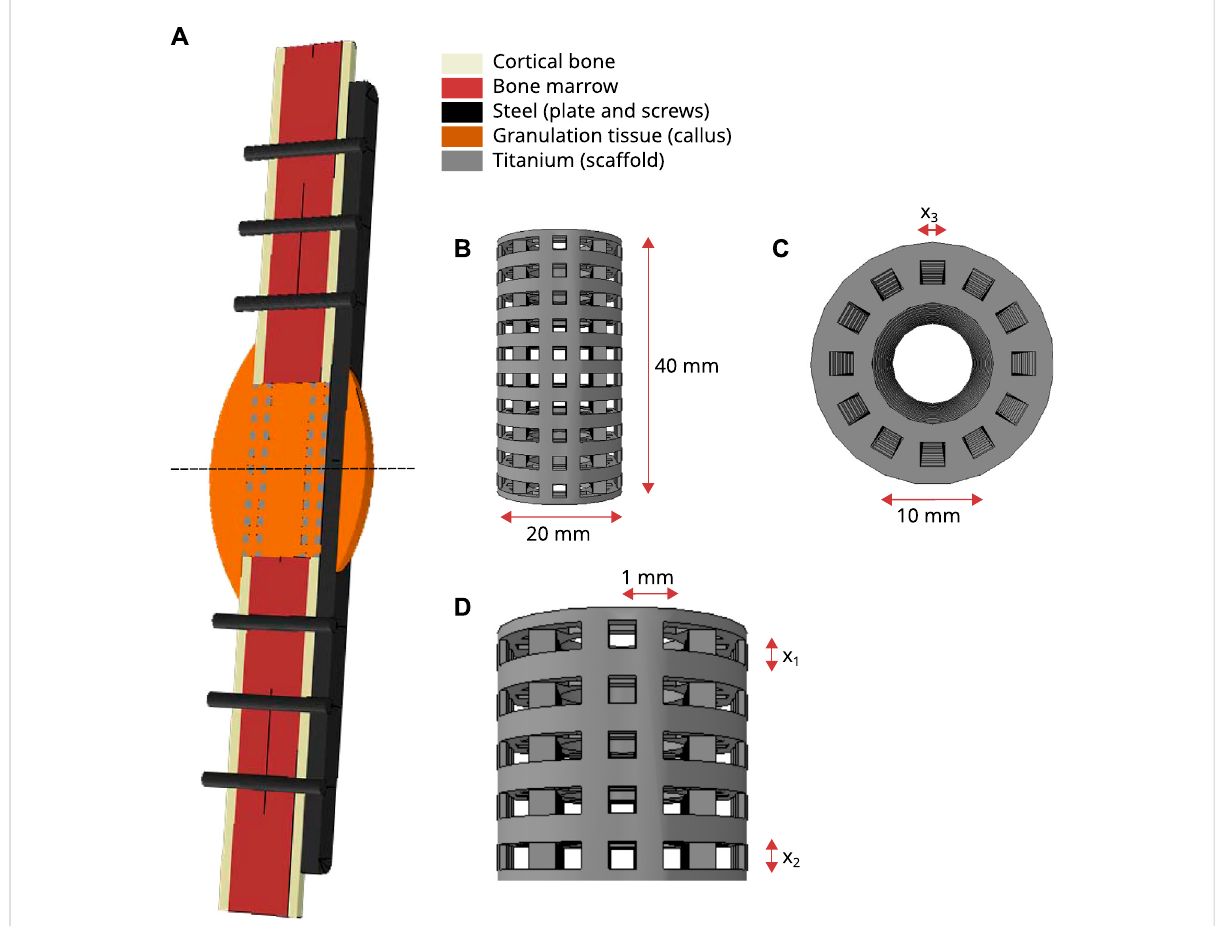
FIGURE 1 (A) Finite element model set-up: longitudinal cut through the defect con fi guration showing the intact bone extremities, the implanted scaffold andthe fi xationplate;thedashedlinerepresentsthesymmetryplaneusedintheanalysis. (B – D) Cylindricalscaffolddescriptionandparametrization: (B) longitudinal view of the full scaffold geometry; (C) radial view of the scaffold de fi ning the vertical pore size parameter x 3 ; (D) longitudinal view of the half scaffold (taking advantage of the symmetry) de fi ning the horizontal pore size parameters x 1 and x 2